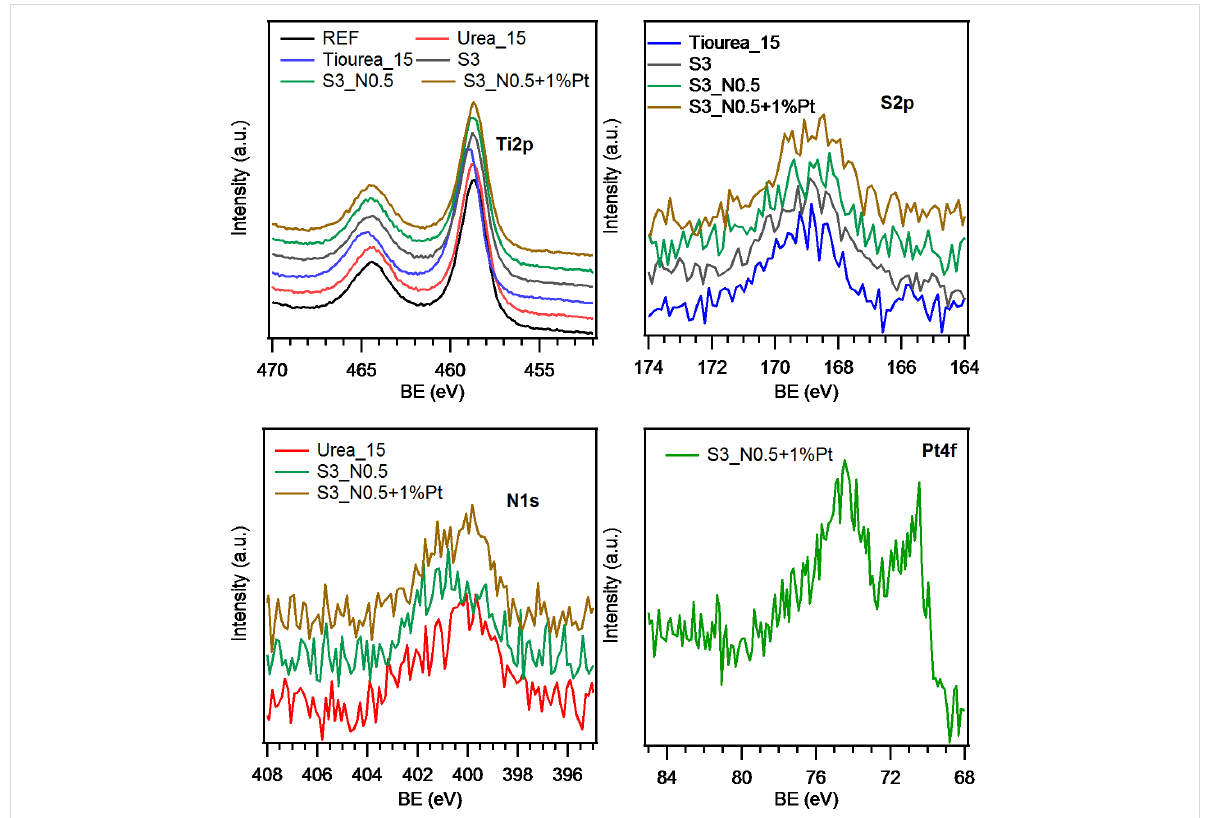
Figure 5: X-ray photoelectron spectra for selected specimens, reporting the Ti 2p, S 2p, N 1s and Pt 4f peaks.